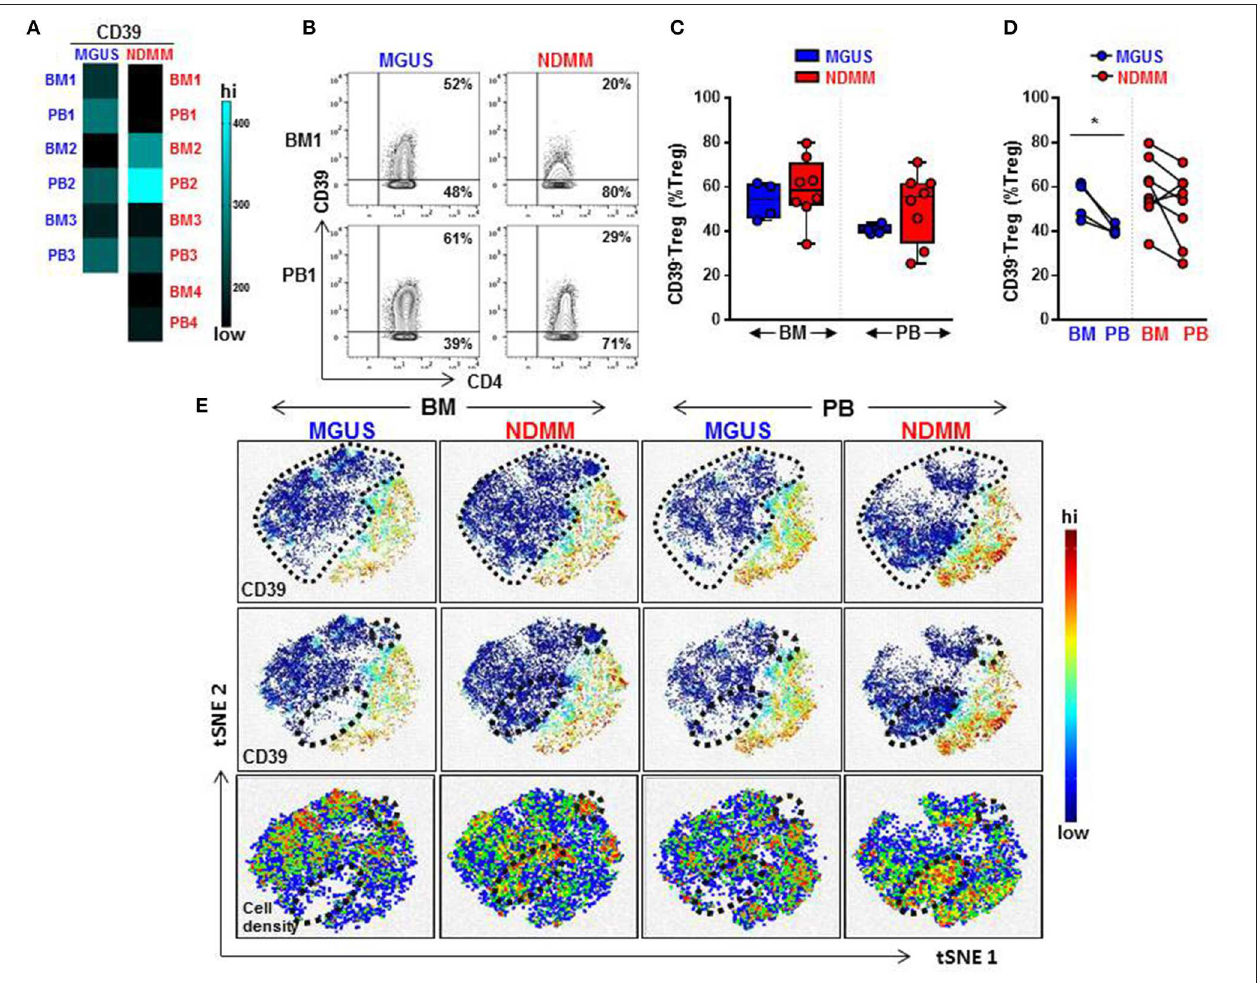
FIGURE 2 | Frequency of CD39 − Treg increases in NDMM compared to MGUS patients. Mass Cytometry data: (A) Heatmap of median signal intensity of CD39 expression on Treg in matched PB and BM from MGUS ( n = 3) and NDMM ( n = 4) patients. (B) Representative biaxial plots of CD39 vs. CD4 expression in the Treg compartment (CD25 + CD127 low / neg ). Numbers indicate percentage of CD39 + and CD39 − Treg. (C) Frequency of CD39 − Treg in BM and PB of MGUS ( n = 4) and NDMM ( n = 8) patients obtained by biaxial gating shown in (B) . Box and whisker plots show min and max, with median and individual data points. (D) Frequency of CD39 − Treg in paired BM and PB of MGUS ( n = 4) and NDMM ( n = 8) patients. Mann-Whitney- U -test and Wilcoxon matched-pairs signed rank test; * p < 0.05. (E) t-SNE plots of the Treg compartment in pooled BM and PB of MGUS ( n = 3) and NDMM ( n = 4) patients. t-SNE plots show clustering patterns of CD39 + Treg (top, middle panels) and cell density (bottom panels). Area occupied by CD39 − Treg (top panel) and distinct regions which are occupied differently by CD39 − Treg (middle, bottom panels) are